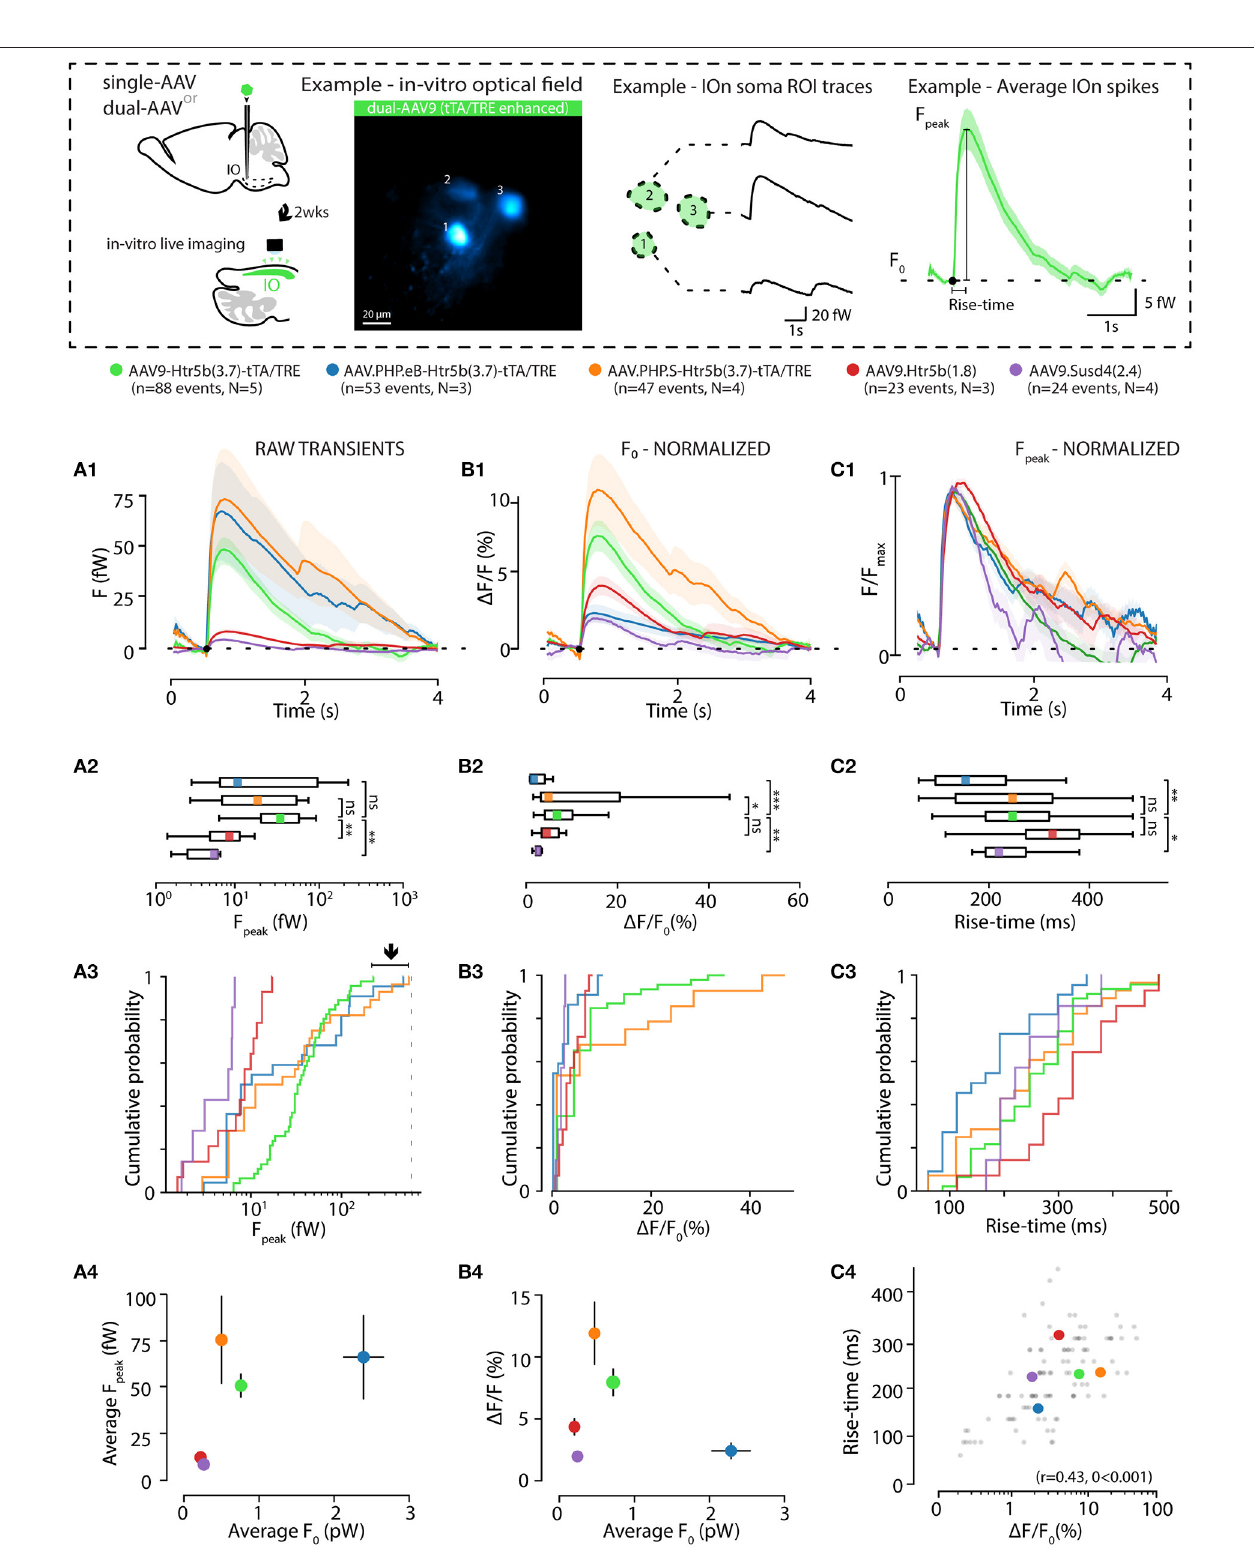
FIGURE 5 | Effects of GCaMP6s expression level on the action-potential-related fluorescence signal. (A,B) Comparison between calcium events in units of power (fW) obtained with the 5 different constructs as indicated by the color labels, 2 weeks after injection. The schematic examples on top of the figure (in a dashed-line box; note that the image brightness of the standard deviation time series projection is adjusted for viewing and should not be considered as representative of the dynamic range during live imaging) describe extraction of the calcium fluorescence event parameters in acute IO slices. (A1) Averaged event waveforms aligned on